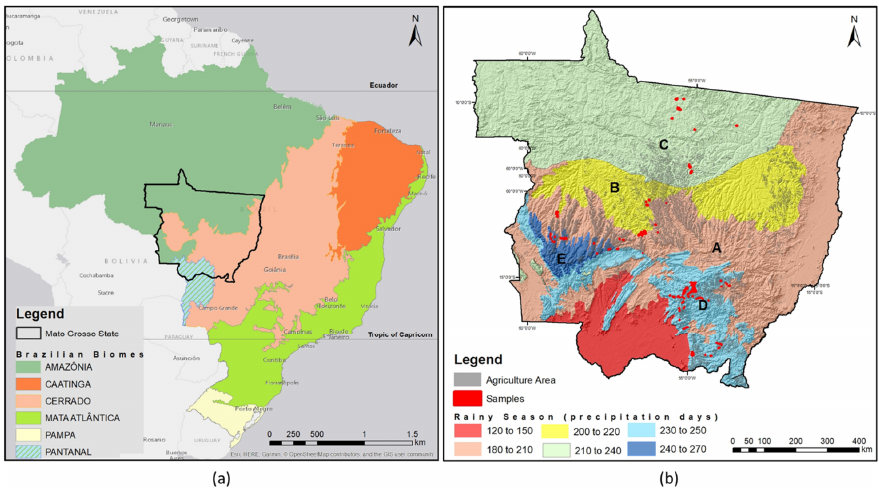
Figure 1. Study area: ( a ) Location of Mato Grosso state in Brazil and biomes map; ( b ) Agroclimatic maps of Mato Grosso state established in a previous study [36]; Cropland extent in 2017 is indicated in grey mapped by Camara et al. [27], and the ground samples are indicated in red (2018/2019). The predominant climate types are tropical, super-humid monsoon climate (with an annual average of 2000 mm) and tropical climate (with summer rains and dry winters with precipitation above the annual average of 1 500 mm [37]). It still has an interannual climate variability (Figure 2) due to the phenomena of the South Atlantic Convergence Zone (SACZ), the Intertropical Convergence Zone (ITCZ) and the “ENSO” (El-Niño— Southern Oscillation) phenomena. Figure 2. Histogram depicting monthly rainfall distribution for Mato Grosso in different years.